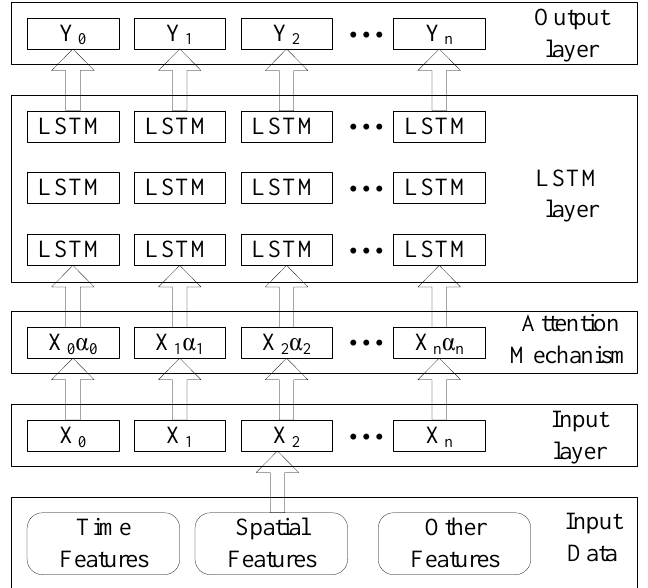
Figure 3. LSTM + Attention model flow chart.